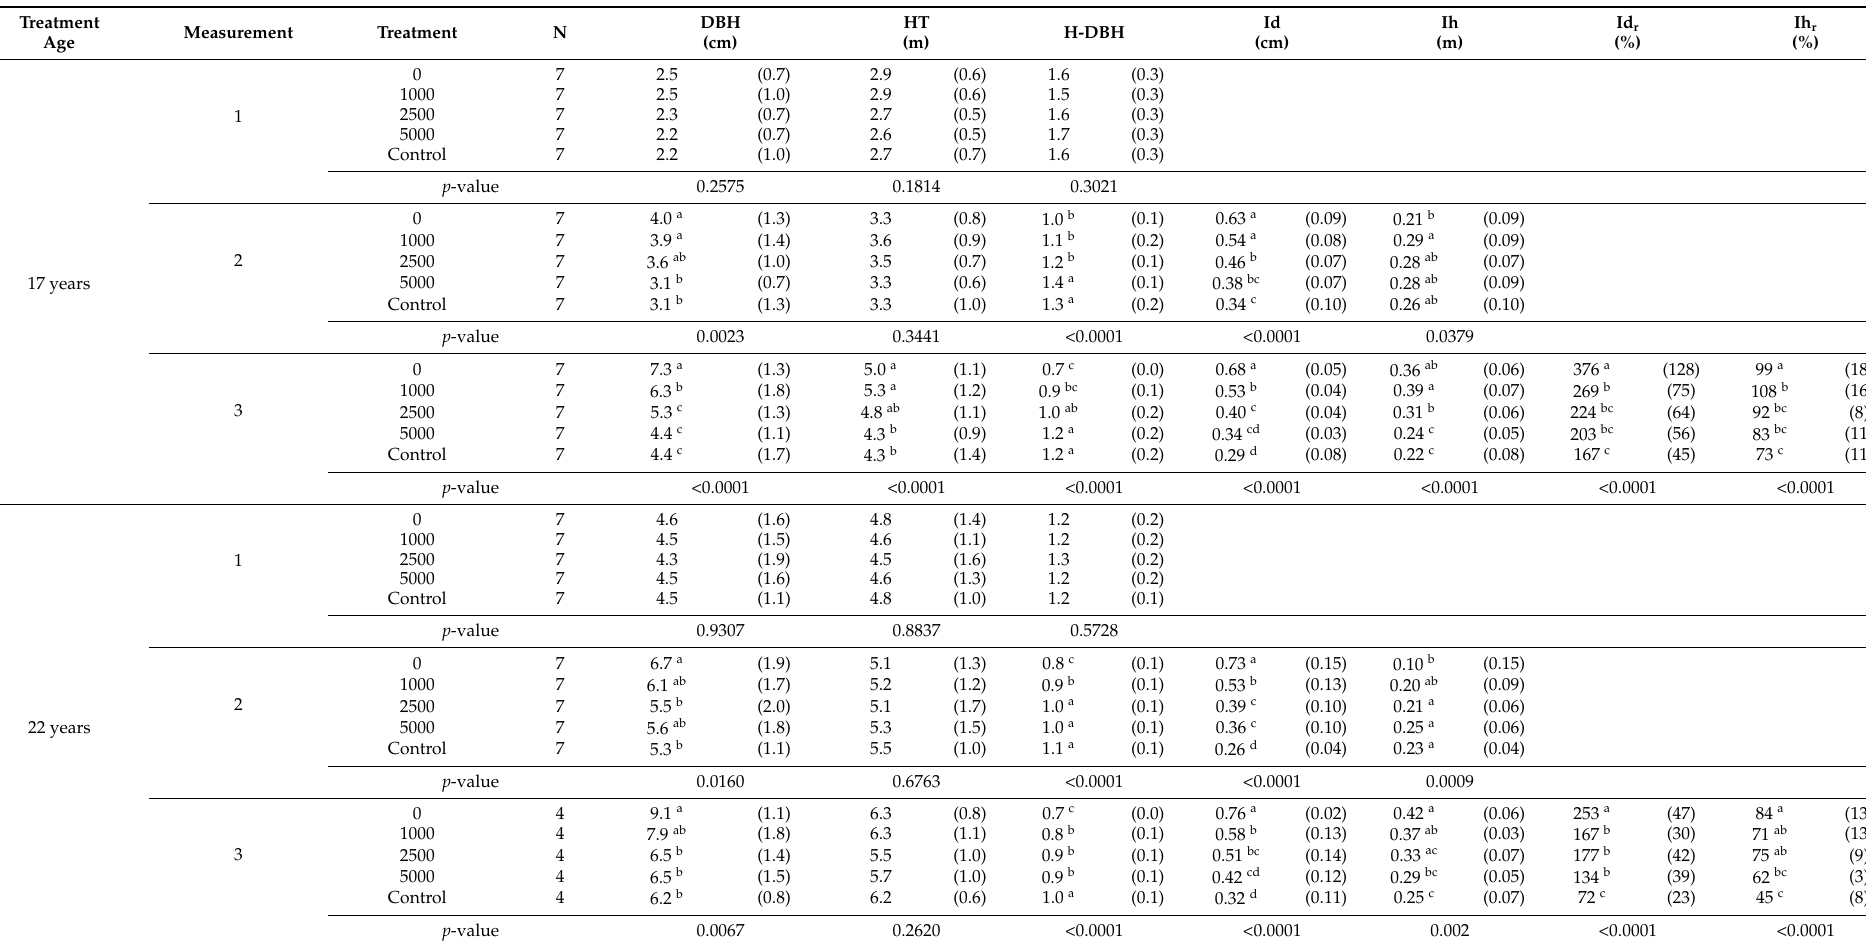
Table 3. Treatment means and standard deviations (shown in parentheses) for post-treatment measurements of planted white spruce. p -values are from mixed-model ANOVA; means within measurement and treatment age followed by different letters are significantly different based on Tukey’s post-hoc test with Bonferroni’s adjustment. N—sample size; DBH—mean diameter at breast height (1.3 m); HT—mean height; H-DBH—mean height-to-DBH ratio; SR—mean periodic survival rate; Id—mean periodic annual diameter increment;